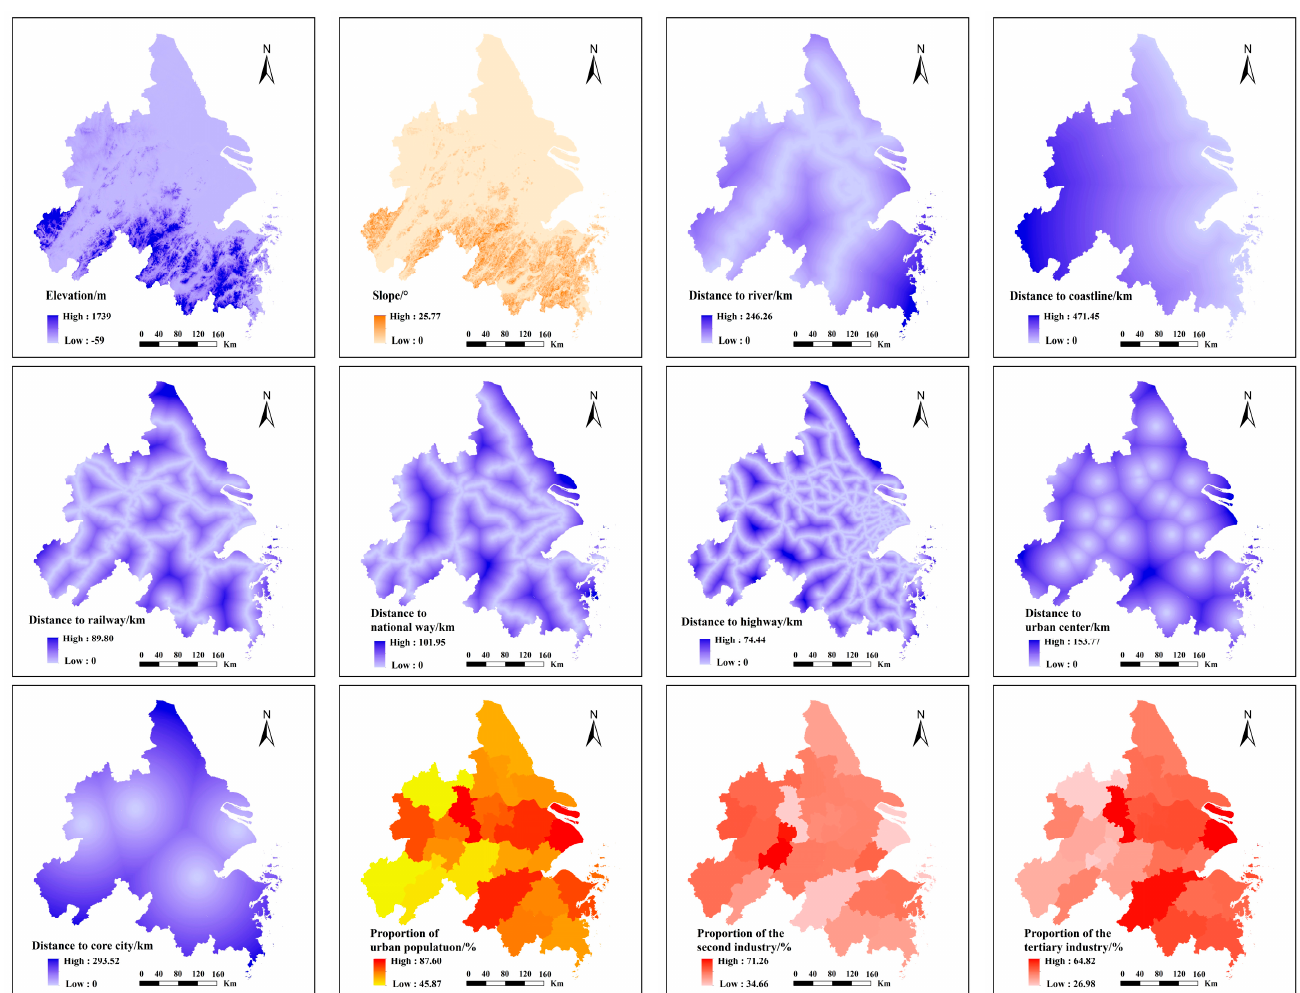
Figure 4. Spatial mapping of the drivers of construction land development in the YRD urban